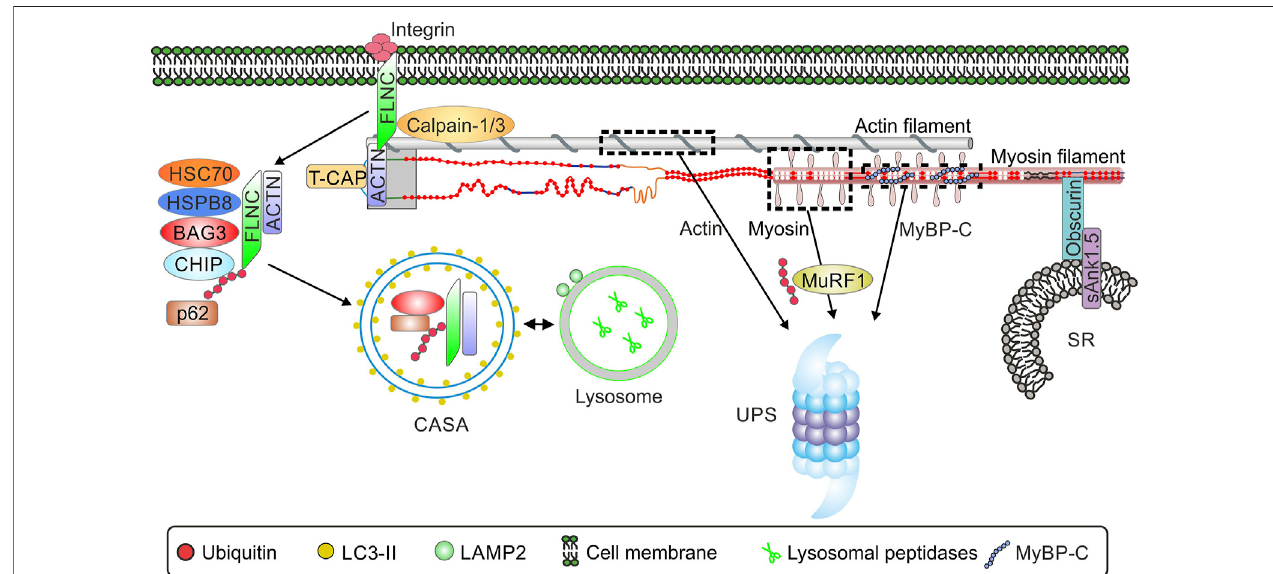
FIGURE 3 | Schematic overview of the interaction of sarcomere and selected sarcomere-associated proteins and protein quality control. Abbreviations: ACTN, α - actinin; BAG3, Bcl2-associated anthanogene 3; CASA, chaperone assisted selective autophagy; CHIP, Carboxy terminus of HSP70 interacting protein; HSP70, heat shockprotein70;HSPB8,heatshockproteinfamilyBmember8;LAMP2,Lysosome-associatedmembraneprotein2;LC3,microtubule-associatedprotein1lightchain 3; MuRF-1, muscle speci fi c ring fi nger 1; p62, sequestosome-1/p62; sAnk1.5, Small ankyrin-1 isoform 5; FLNC, fi lamin-C ; UPS, ubiquitin-proteasome system; SR, sarcoplasmatic reticulum. TCAP,